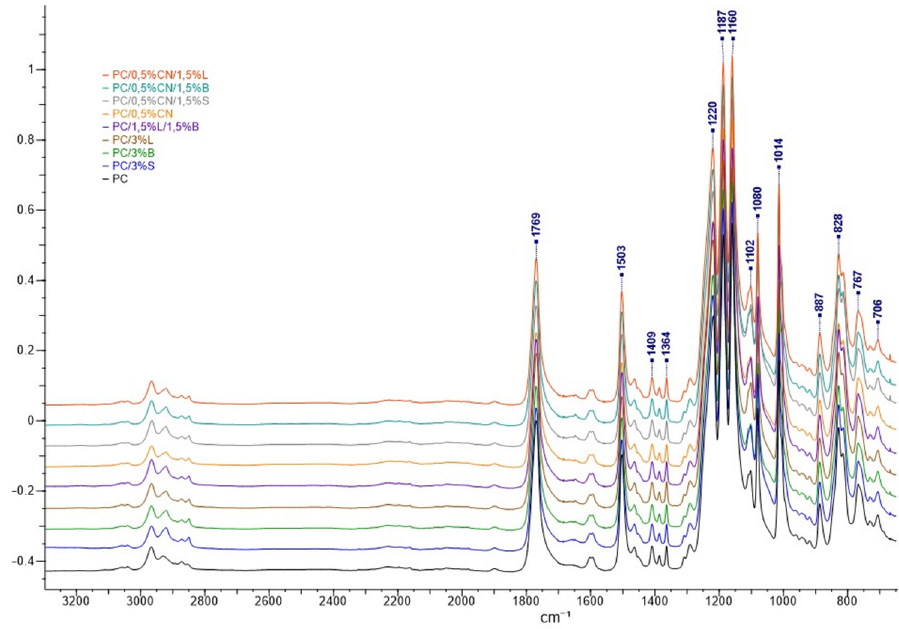
Figure 14. FT-IR spectra recorded for the composition.